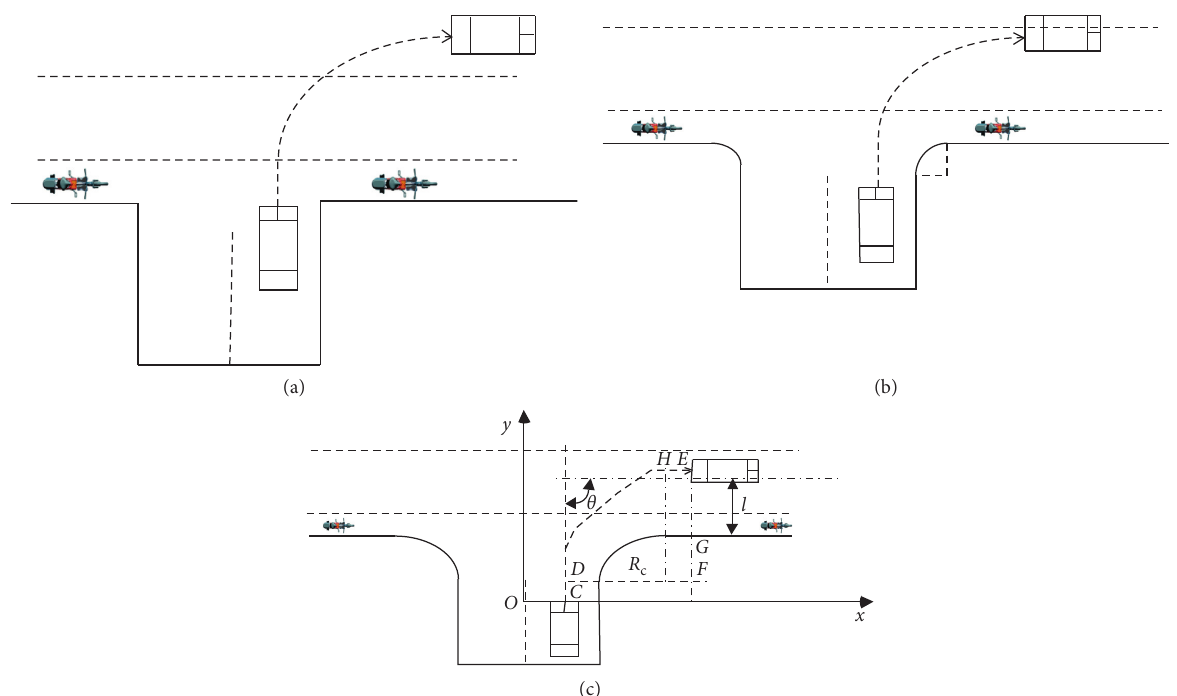
Figure 13: Right turns on the driveway. (a) Driveway without exiting radius. (b) Driveway with small exiting radius. (c) Driveway with large exiting radius.